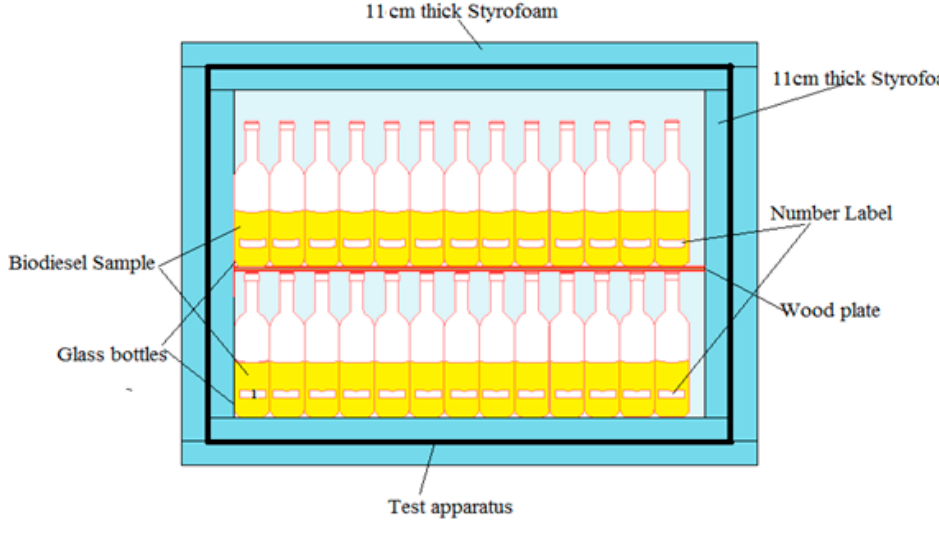
Figure 2. Glass bottles in test apparatus.